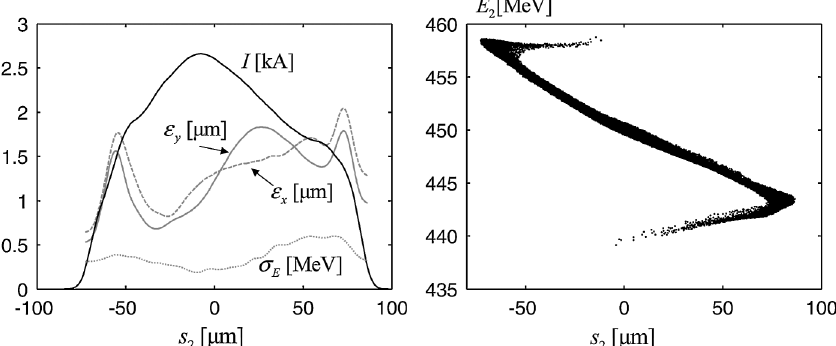
FIG. 11. The properties of the bunch after the second bunch compressor as obtained by 3D self-consistent